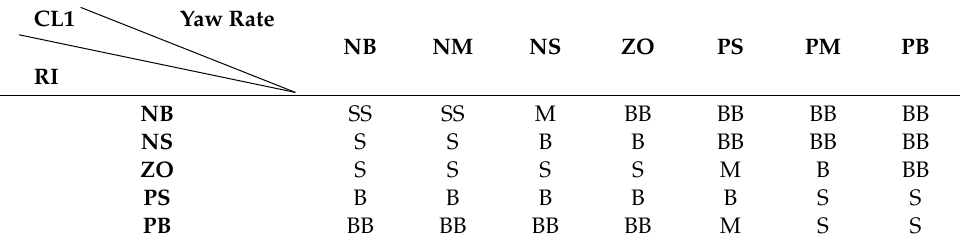
Table 2. Fuzzy rule: RI, yaw angle rate and damping reference coe ffi cient of front right wheel.